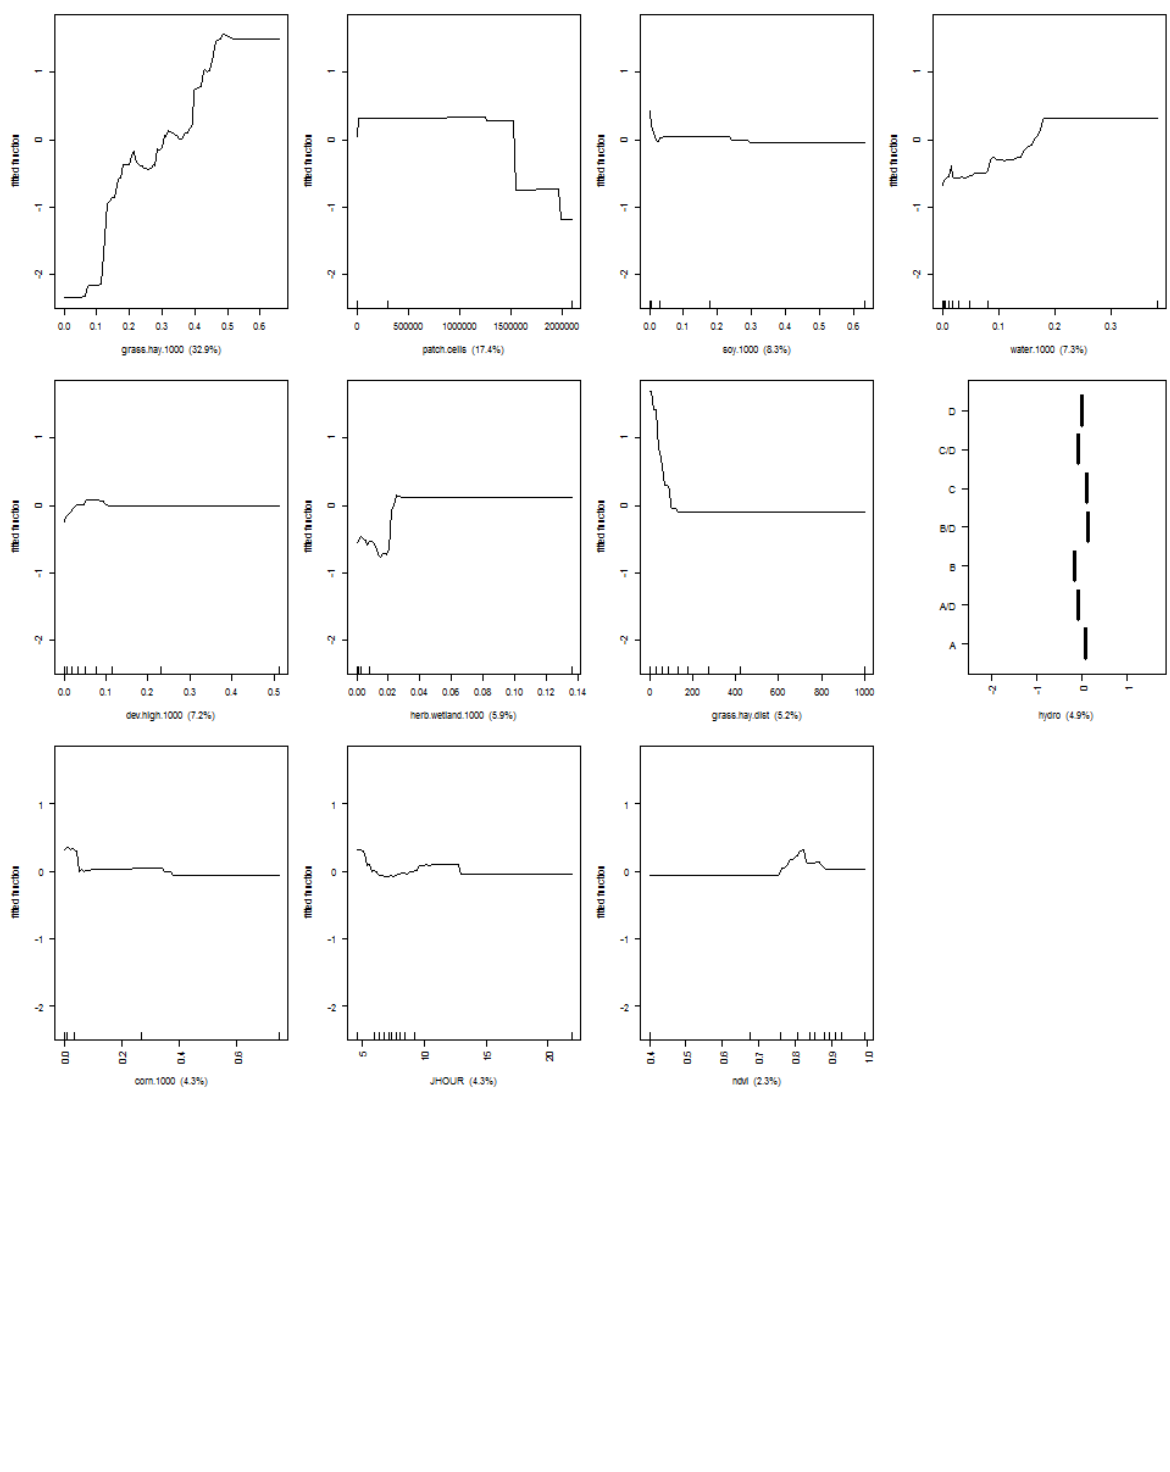
Figure A1.4a. Response curves for